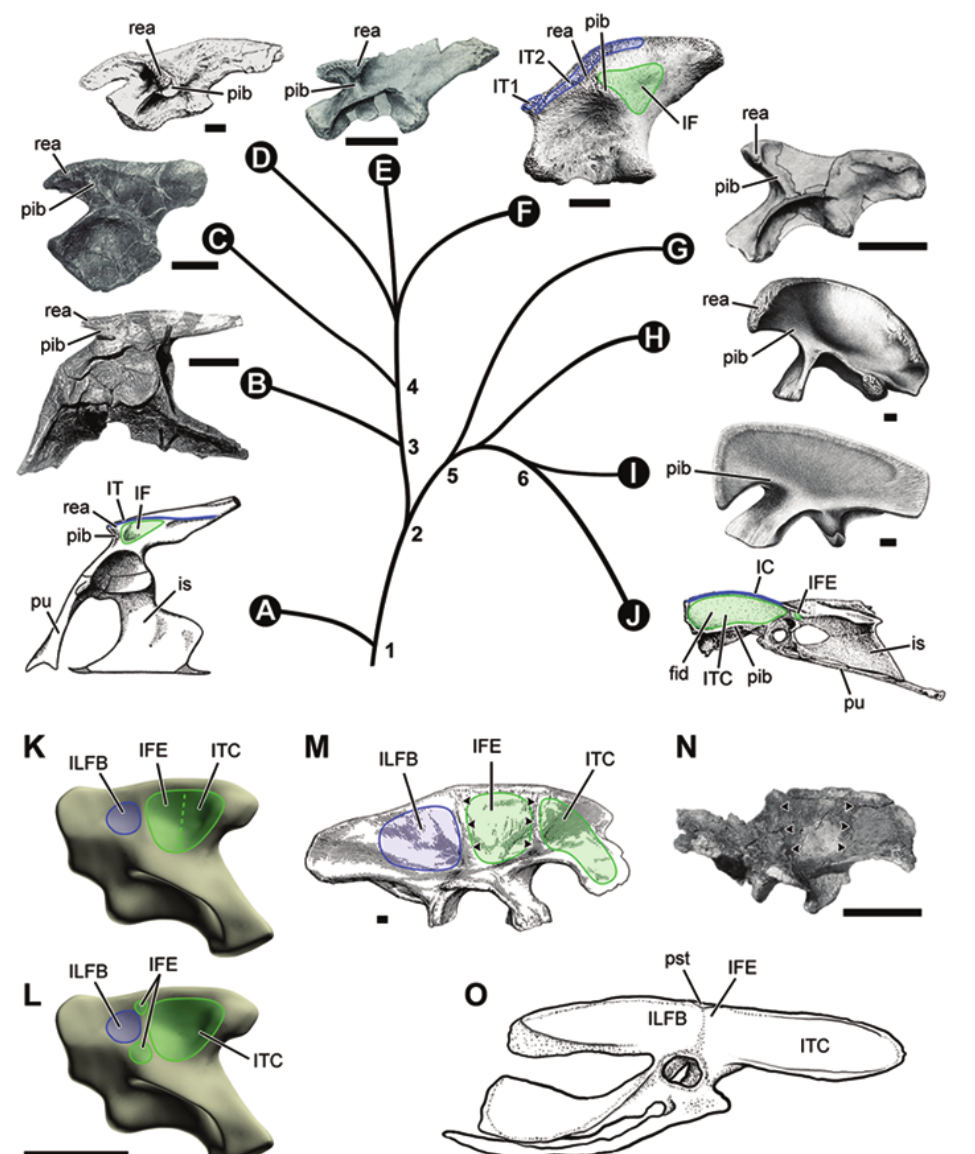
Fig. 3 – Iliac structures associated with muscle origin. A-J: Evolution of the preacetabular iliac border ( pib ) and the associated rough expanded area ( rea ) in Diapsida and its relationship with the origin of the muscles IT, IC (blue areas in A, F and J) and IF, IFE and ITC (green areas in A, F, and J). Number and letters correspond to the following taxa: (1) Diapsida (A – Iguana , Lepidosauromorpha), (2) Archosauria, (3) Crurotarsi (B – Leptosuchus ,Rutiodontidae),(4)Suchia(C– Stagonolepis ,Aetosauria; D– Lythrosuchus ,Poposauridae; E– Postosuchus [juvenile],Rauisuchidae; F – Caiman , Crocodylomorpha), (5) Saurischia (G – Caseosaurus , Basal Saurischia [right ilium reversed]; H – Apatosaurus , Sauropodomorpha) and (6) Avetheropoda (I – Allosaurus , Carnosauria; J – Meleagris , Aves). K-O: Relationship between the position of the areas of origin of ITC, IFE and ILFB in Staurikosaurus (K, hypothesis adopted in this work; L, two hypothesis proposed by Langer 2003), Tyrannosaurus (M), Sinornithomimus (N) and Crypturellus (O, indicating the relationship of IFE and the processus supratrochantericus, pst ). Arrowheads in M and N indicate the convex borders that may indicate anterior and posterior limits of IFE. Scale bars: 50 mm (A – after Romer 1922, 1923c, 1956; B-E and G – from Long and Murry 1995; F – muscle disposition according to Romer 1923c; H – from Ostrom and McIntosh 1999; I – from Madsen 1993; J, O – from Hutchinson 2001a; M – from Osborn 1916; N – from Kobayashi and Lü